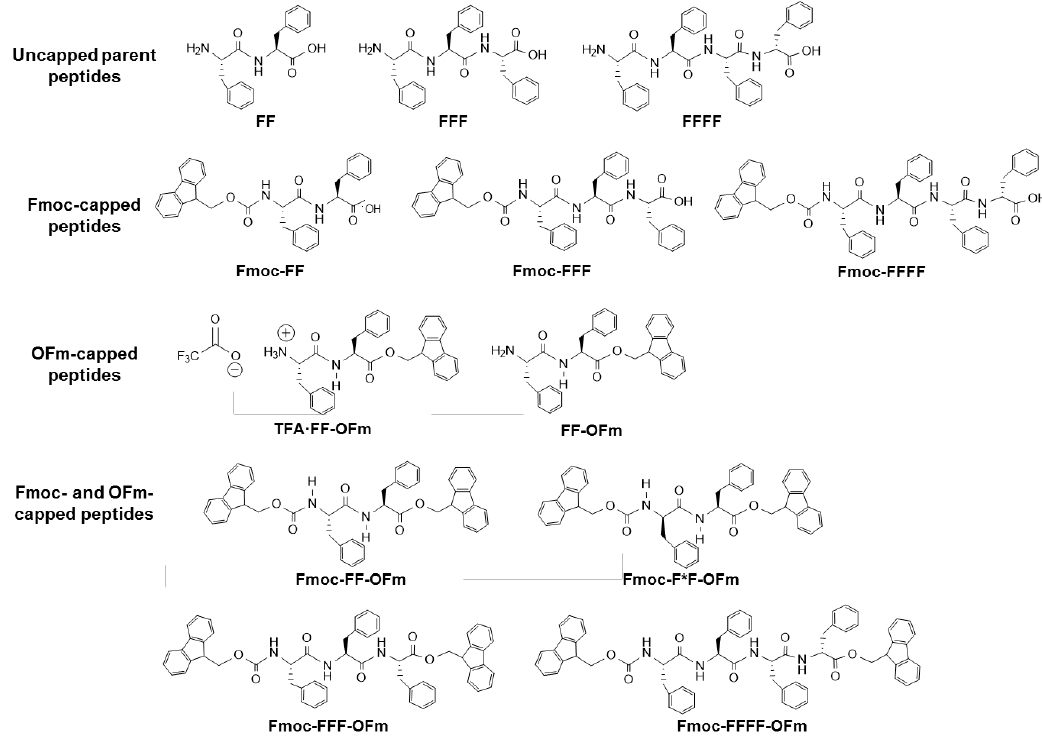
Figure 1. Chemical structures of the peptides examined in this work.